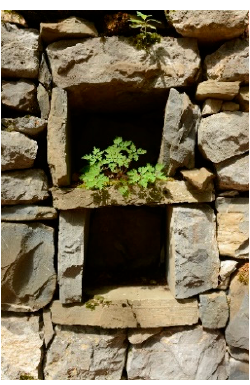
Figure 11. An entrance into dubirog - katun Crna rupa, photo: I. Lakovi ć .